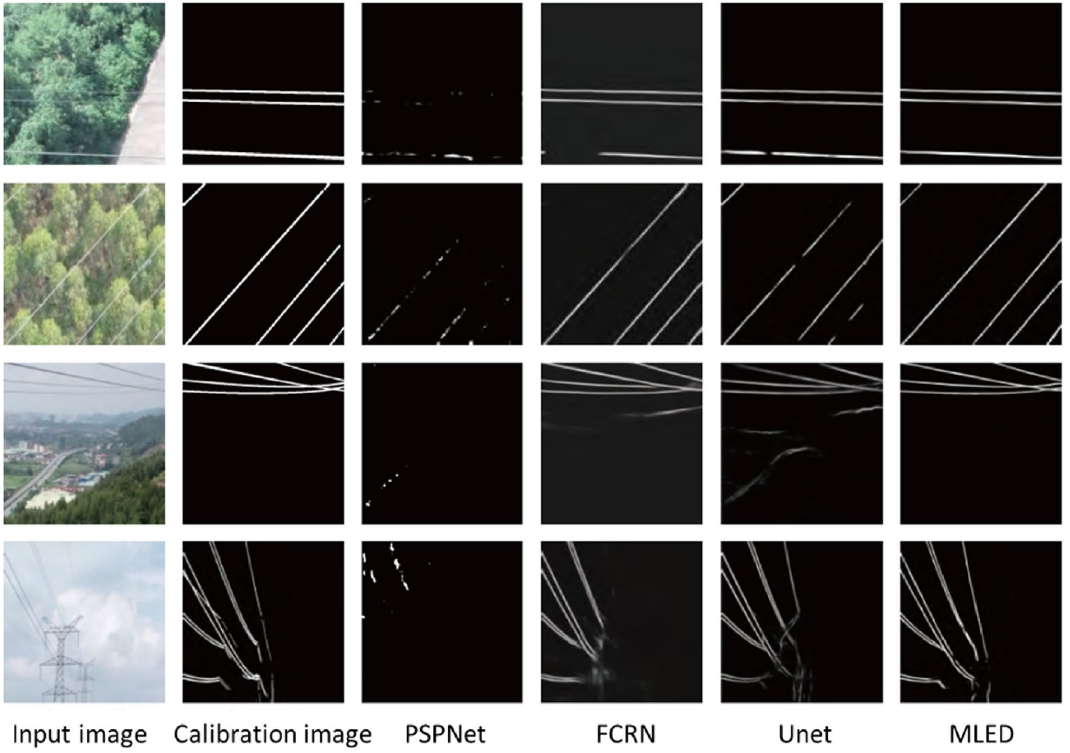
Fig. 6 Comparison between MLED and mainstream